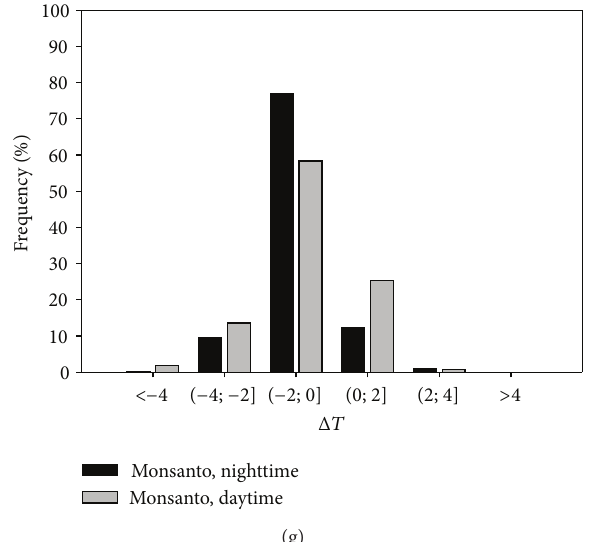
Figure 4: Frequencies of air temperature deviations between the observation points and the Portela Airport meteorological station. Low intensity : urban-rural differences up to 2 ∘ C; medium intensity: from 2 to 4 ∘ C; strong intensity : > 4 ∘ C (Classification based on Garc´ıa